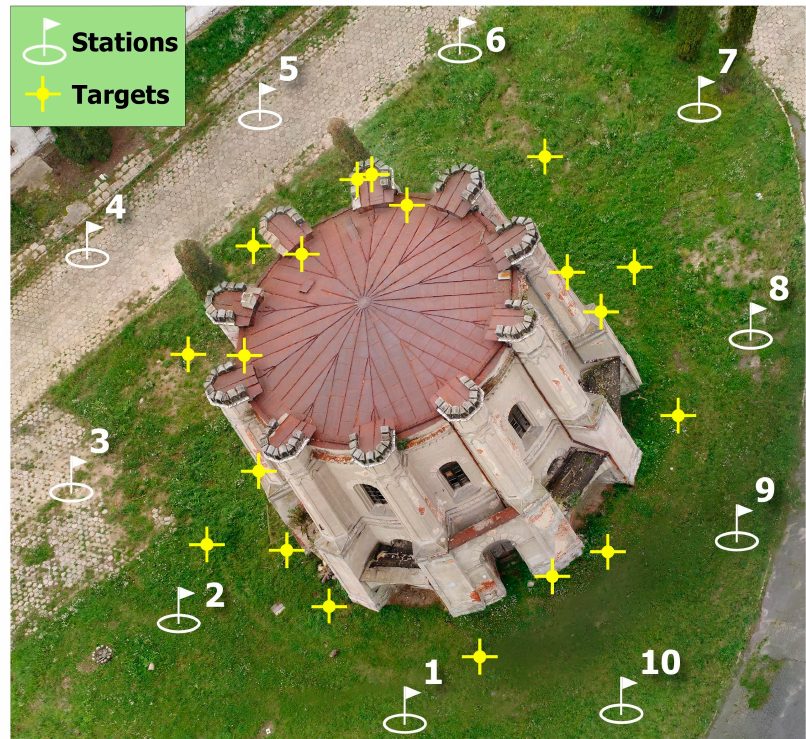
Figure 6. The locations of the TLS stations and the target points.